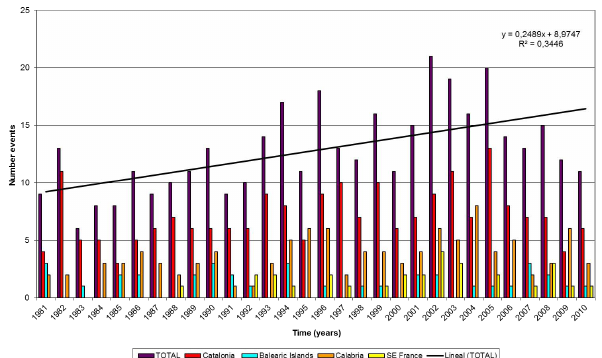
Fig. 7. Interannual flood evolution for all the analysed regions for the period